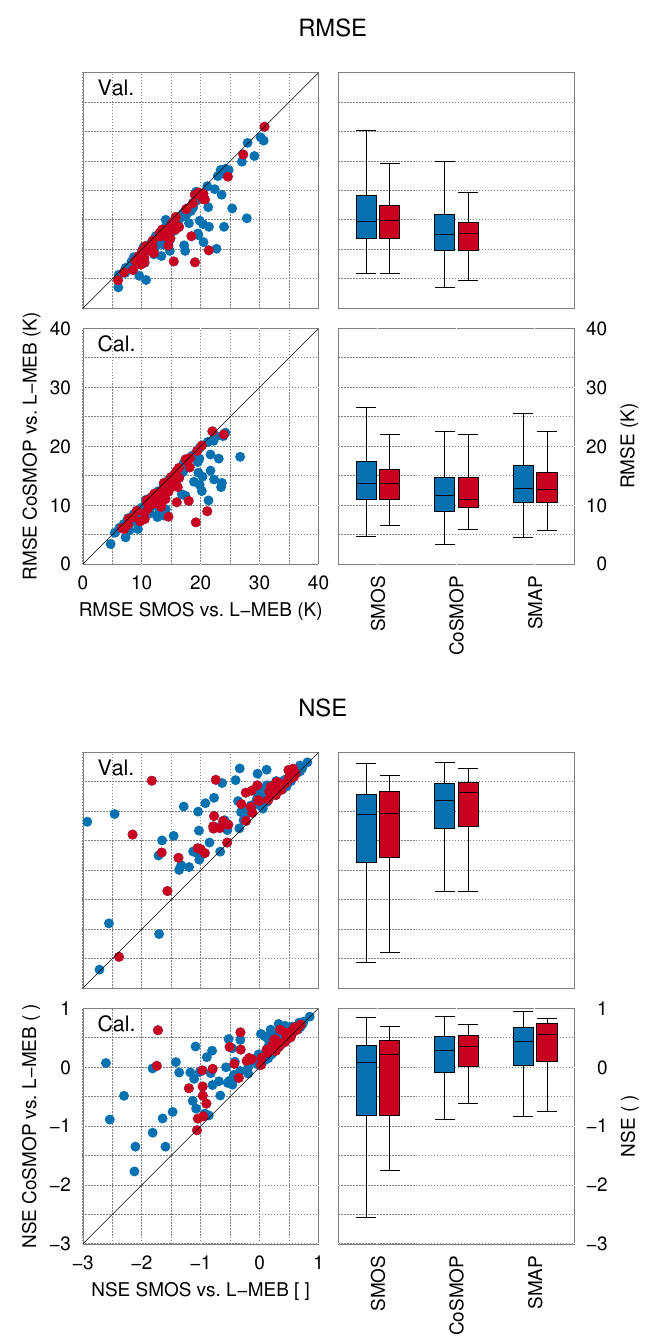
Figure 7. Root mean squared error (top) and Nash–Sutcliffe efficiency (bottom) from SMOS- and CoSMOP-derived daily Tbs with respect to the L-MEB forward simulations during the period April 2010–March 2015 (Val.) and April 2015–March 2018 (Cal.), respectively. Each station is represented by a blue or red dot, while the x- and y-values are given by the RMSE- and NSE-values from the SMOS and CoSMOP Tbs, respectively. Dots below (above) the diagonal line depict stations where improvements can be observed for the RMSE (NSE), respectively. The red dots are the stations that have a (more or less) continuous record during the whole period April 2010–March 2018 (see Figure 1). The corresponding box-and-whisker plots show the median (black thin line), the 25th and 75th percentile (top and bottom of the box) and the tails of the distributions (length of the whiskers) for the ensemble of all (blue) and the continuous (red)